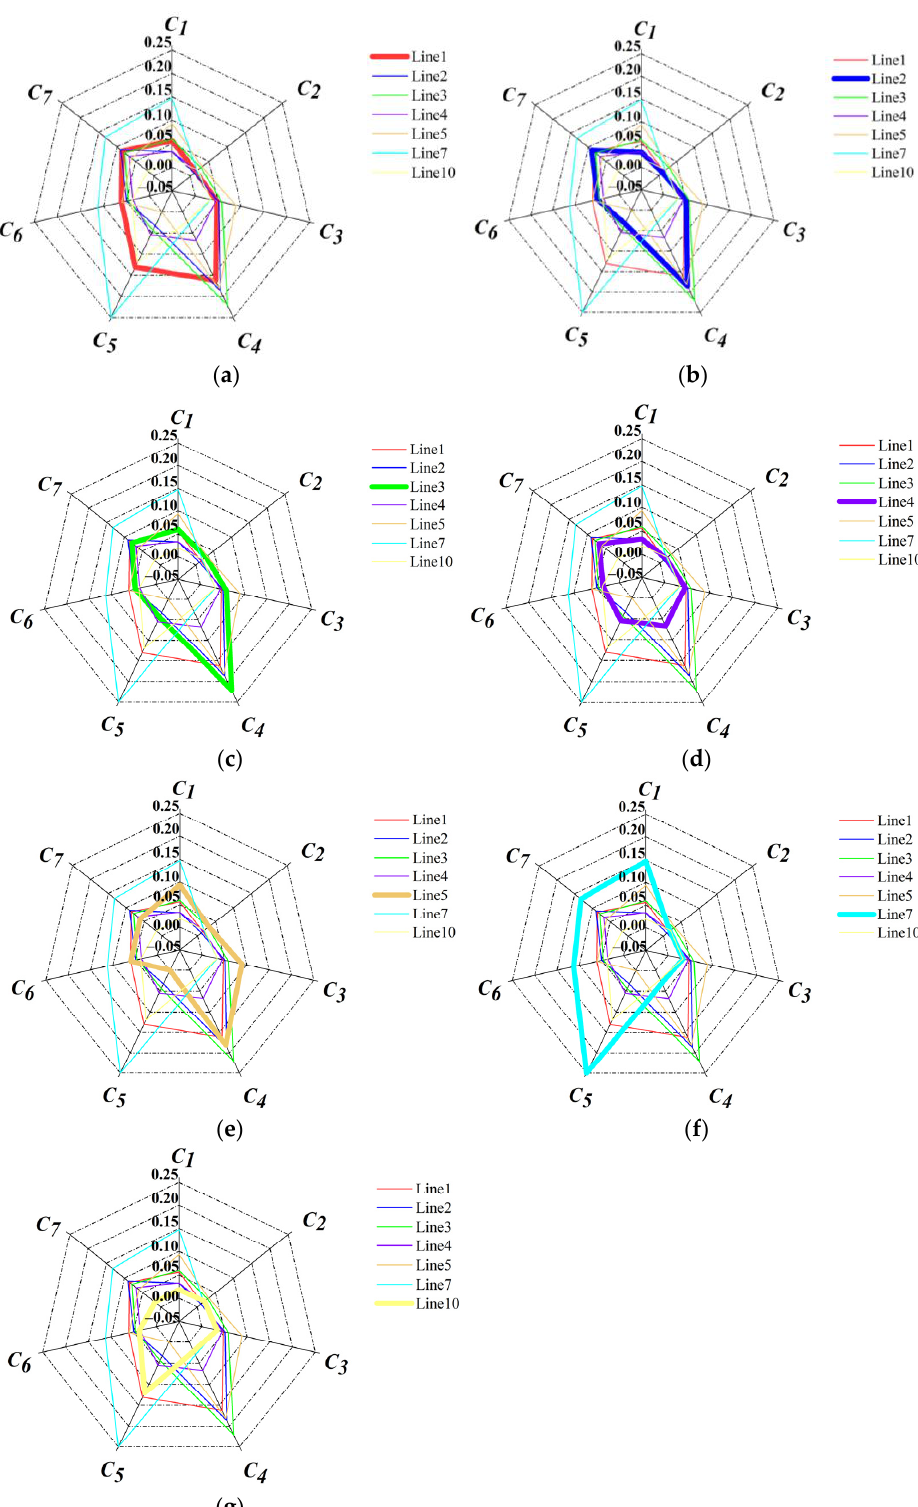
Figure 5. Ranking the seven lines in terms of indicator values. ( a ) The value of indicators of Line 1; ( b ) the value of indicators of Line 2; ( c ) the value of indicators of Line 3; ( d ) the value of indicators of Line 4. None of them stands out; ( e ) the value of indicators of Line 5; ( f ) the value of indicators of Line 7. There are three outstanding indicators; ( g ) the value of indicators of Line 10. None of them stands out.